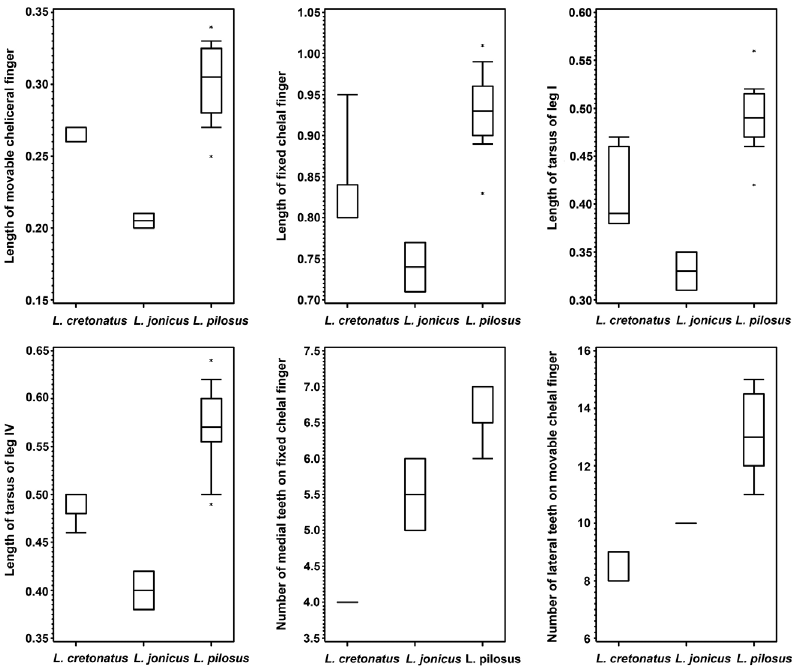
Figure 10. Variation in selected morphological characters of studied Lasiochernes species. Rectangles define the 25 th and 75 th percentiles, horizontal lines show the medians, whiskers are from the 10th to 90th percentiles and asterisks show extreme values (length in